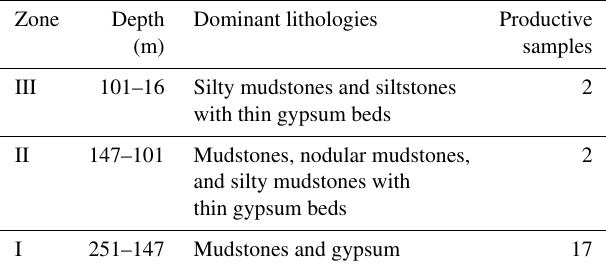
Table 1. Lithologies of the palynological zones identified within the Ria Zhong (RZ) section in the Nangqian Basin, Yushu area, Tibet. Information is given on the stratigraphic horizons of each zone, its dominant lithologies, and the total number of productive palynolog- ical samples that were